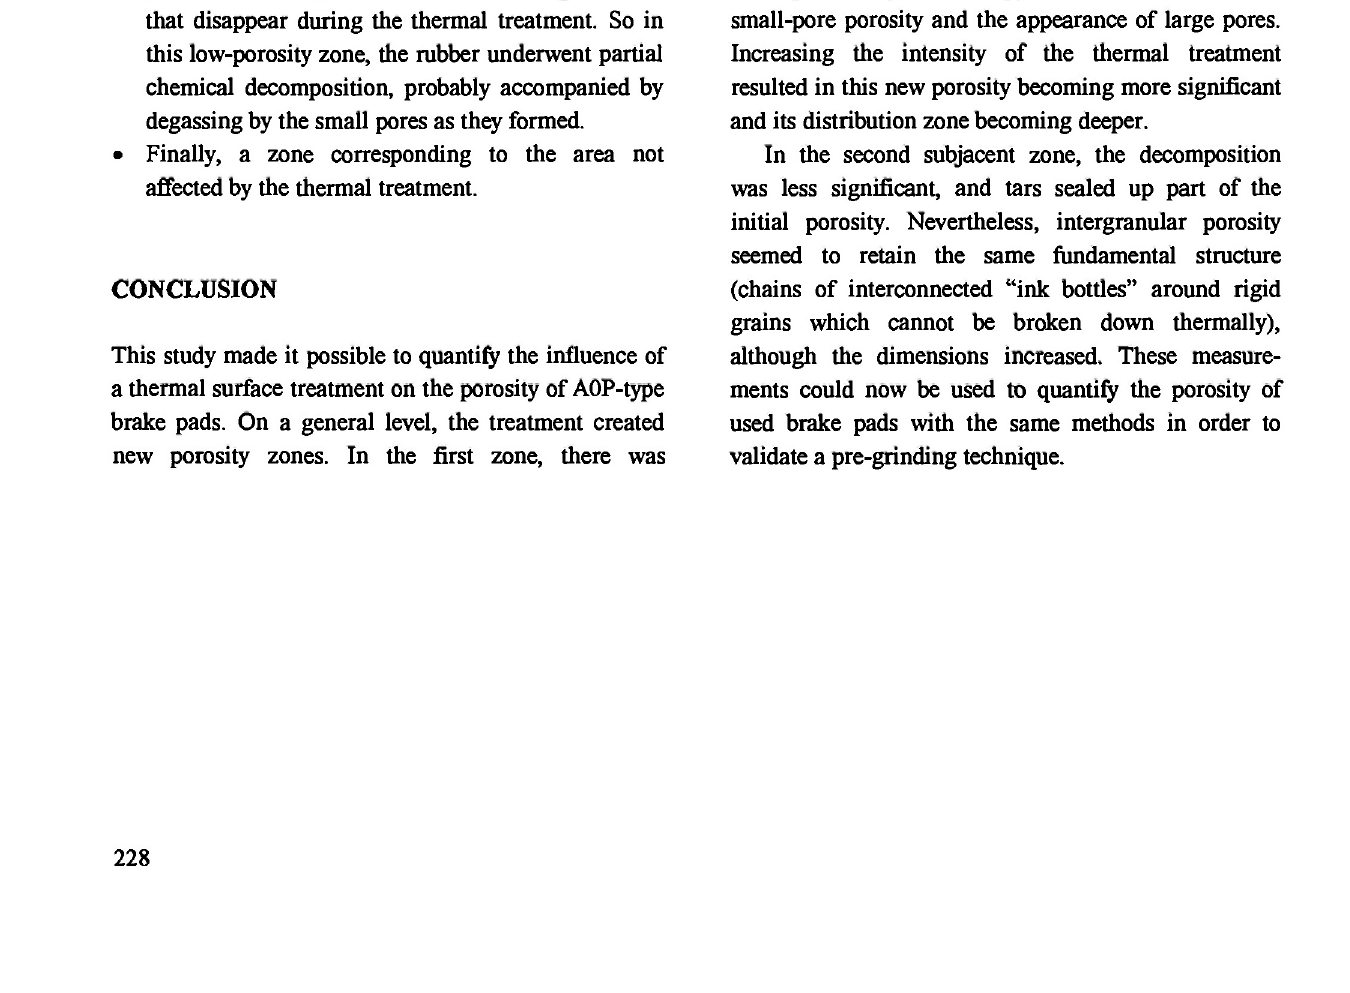
Fig. ΙΠ-5: Distribution of the surface area porosity of A0P10 V5 according to depth. significant decomposition of certain